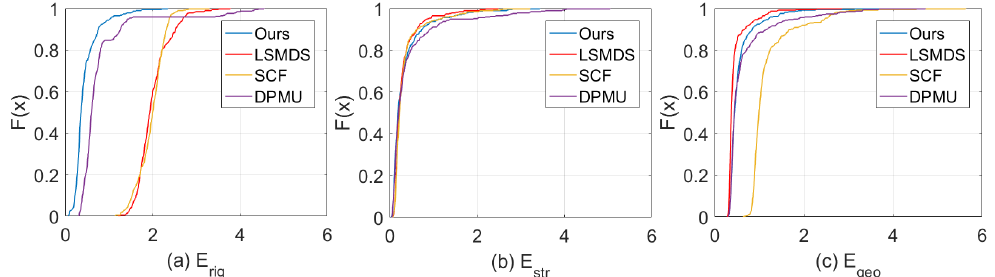
Figure 6. The cumulative probability distributions of E rig ( a ), E str ( b ) and E geo ( c ) for different